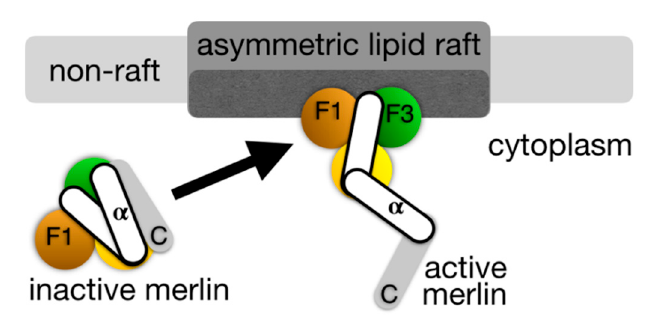
Figure 2. Proposed merlin activation mechanism in lipid rafts. Merlin belongs to the ezrin-radixin-moesin (ERM) family of proteins that are characterized by their N -terminal four point one, ezrin, radixin, moesin (FERM) head domain, a central α -helical domain and a C -terminal tail domain that binds to the actin cytoskeleton. The FERM domain is comprised of three subdomains, F1, F2, and F3 that are arranged in a cloverleaf-like structure (depicted spectrally; F1, orange; F2, yellow; F3, green). The C -terminal domain of merlin differs from other ERM proteins and does not contain an F-actin binding domain. Left , the tumor suppressor protein merlin is inactive in its closed conformer. Right , upon binding to the PI(4,5)P 2 that is found in lipid rafts, merlin is activated by severing its head-tail interaction, thereby resulting in its open conformation and tumor suppressor functions [35].